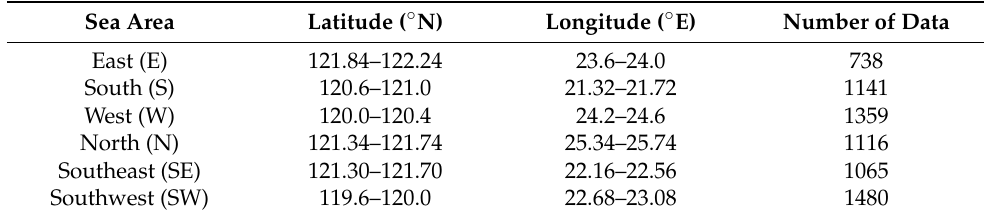
Table 1. The selected sea area for the DINEOF